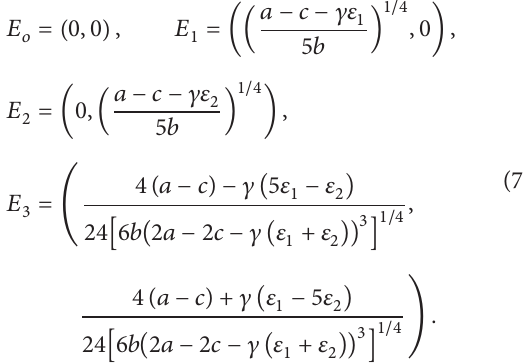
of adjustment, where 𝛼(𝑞 𝑡 𝑖 ) = 𝑘𝑞 𝑡 𝑖 , 𝑖 = 1, 2 , 𝑘 is constant. The